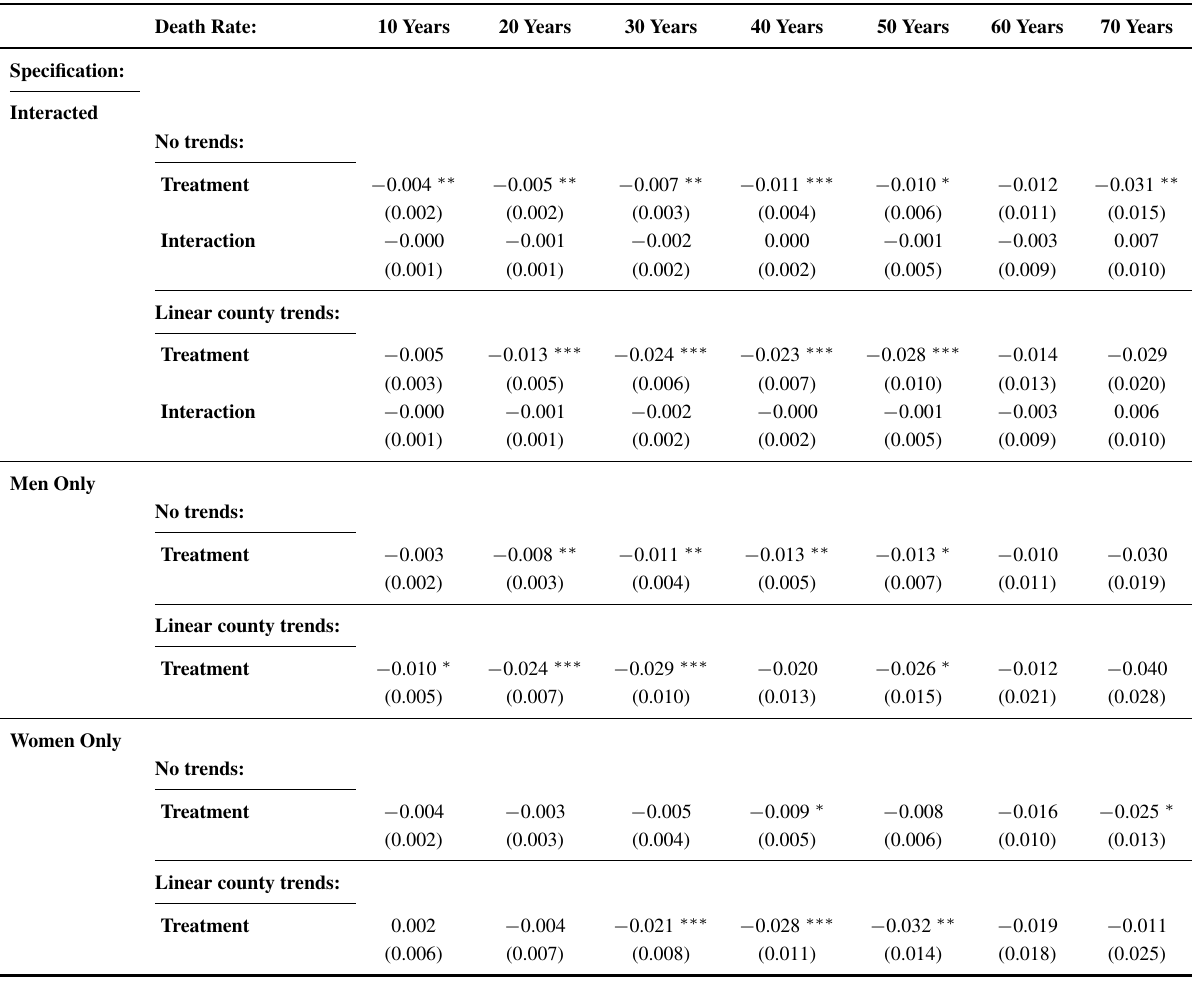
Table 5. Estimation results: gender